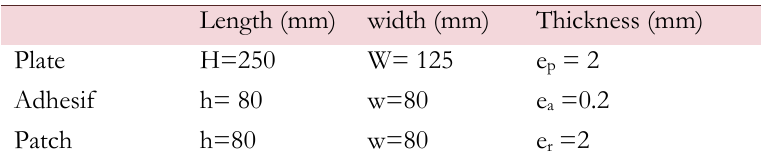
Table 1: Dimensions of the different